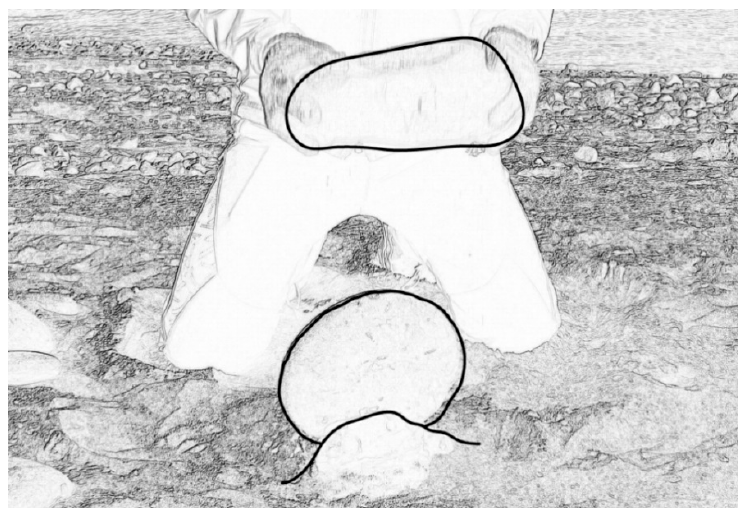
Figure 9. RHBF technique process.